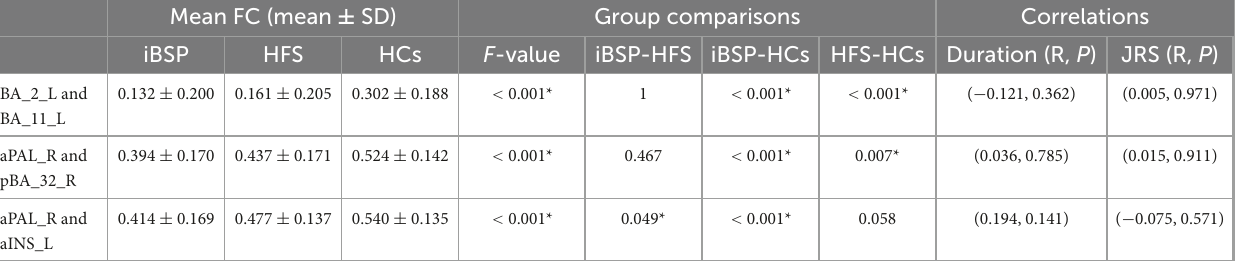
TABLE 4 Differences of resting-state functional connectivity among three groups and their relationships with clinical measurements in iBSP. Mean FC (mean ± SD) Group comparisons Correlations